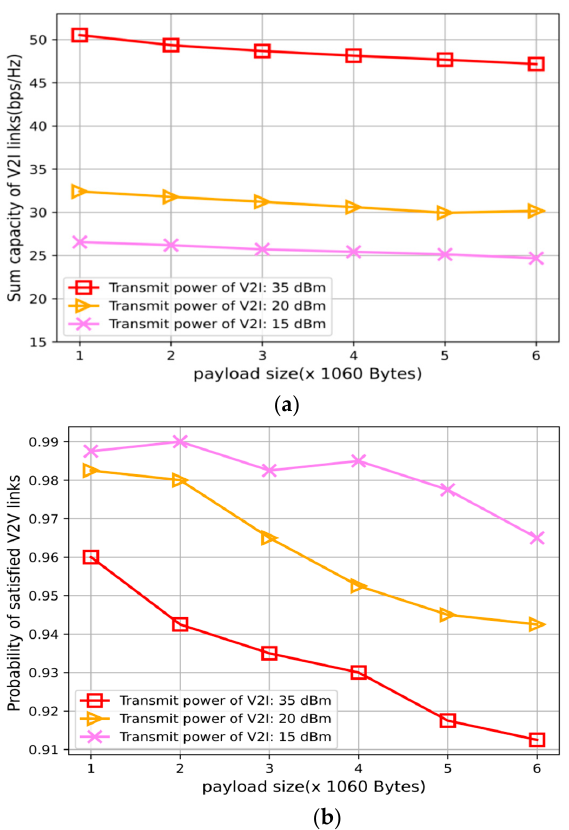
Figure 6. Performance comparisons with varying power. ( a )Sum capacity performance of V2I links with varying power. ( b ) V2V payload transmission success probability with varying